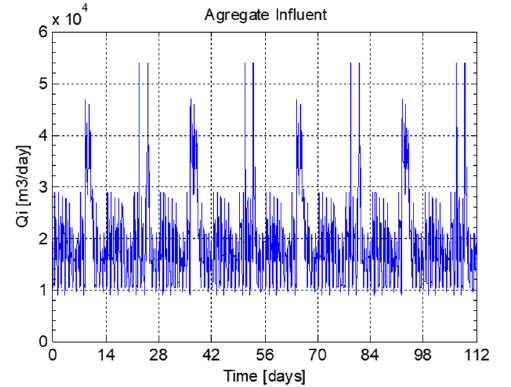
Figure 4. Sequence of operating regimes used in simulations.